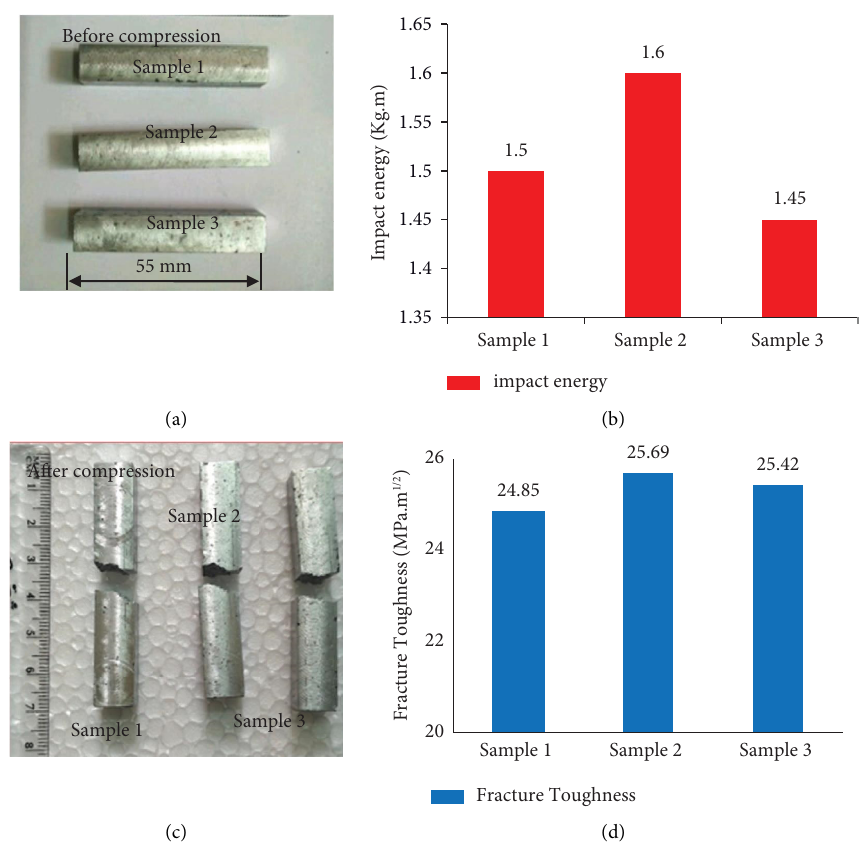
Figure 6: (a) Charpy test specimen before V-notching; (b) impact energy values of the composite specimen; (c) specimen after Charpy test; (d) fracture toughness of composite